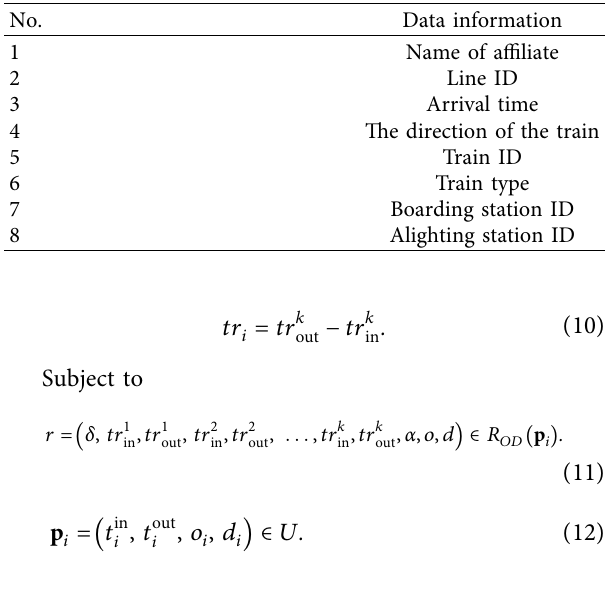
Table 2: Description of the train log